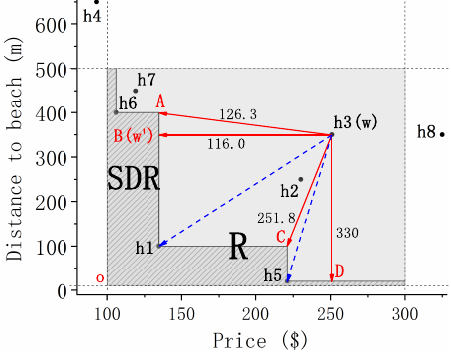
Figure 3. An example of the MWP